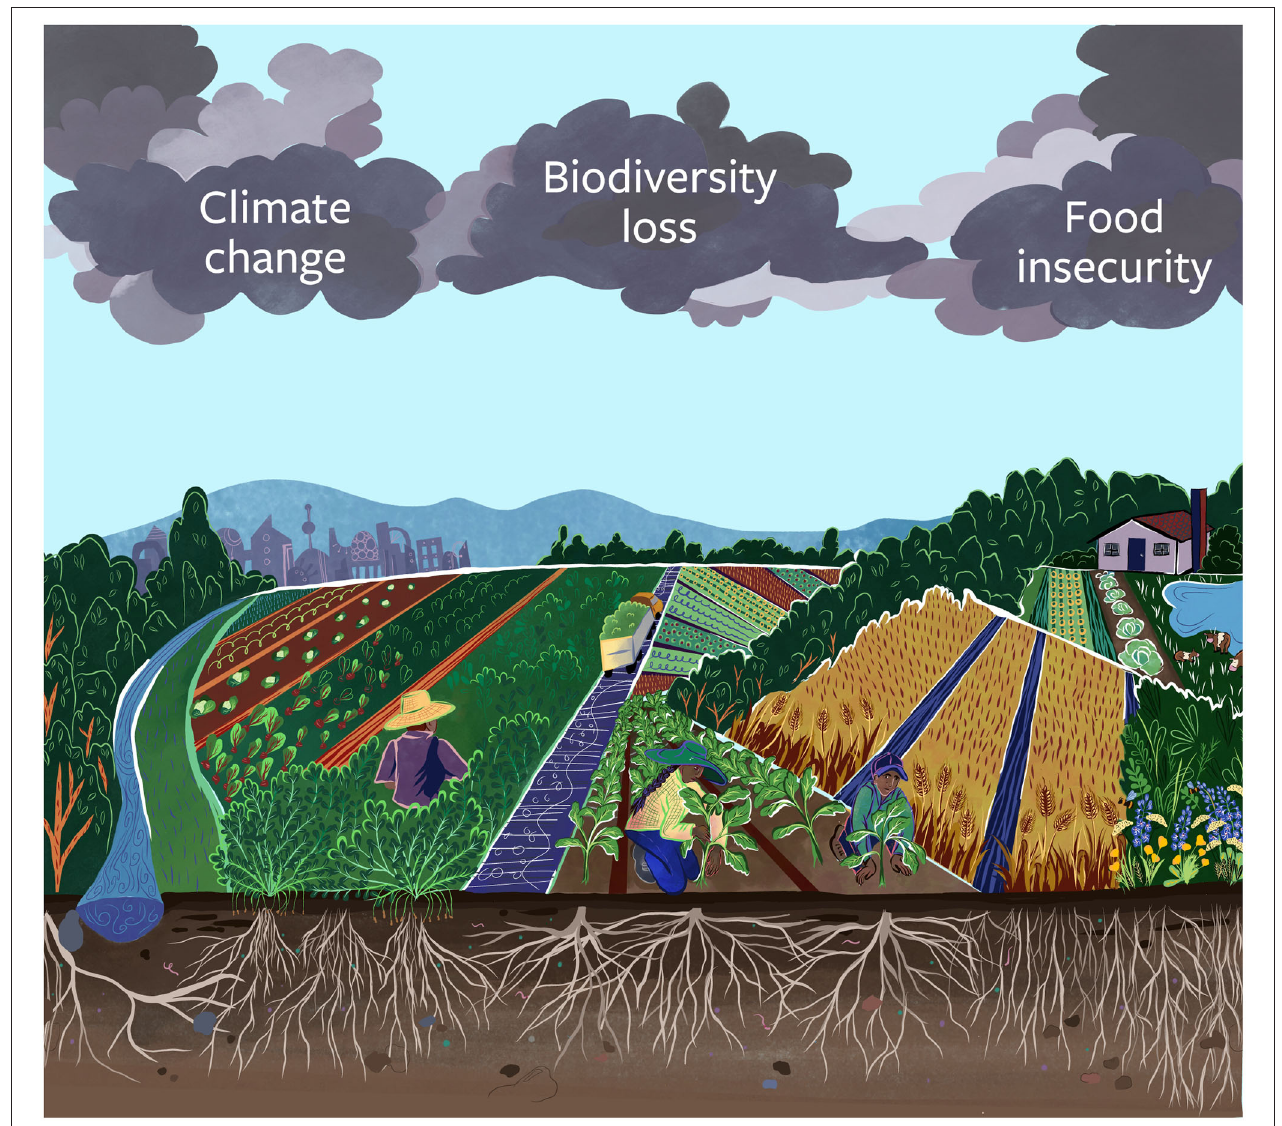
FIGURE 1 | The Anthropocene “triple threat”—climate change, biodiversity loss, and global food insecurity—interact in ways that will exacerbate long-standing climatic, ecological, socioeconomic, and political challenges for agriculture and food systems. The process through which social-ecological systems build adaptive capacity to these looming threats shapes future adaptation and transformation